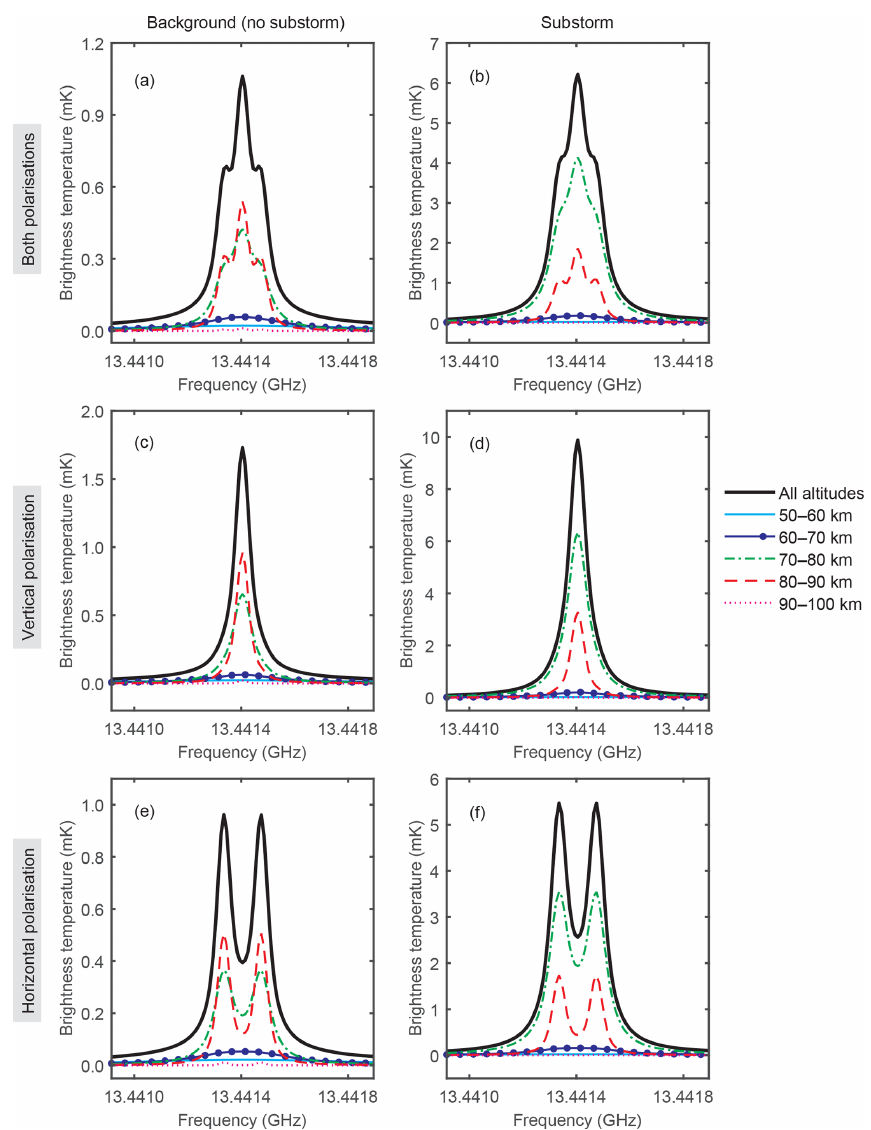
Figure 7. Simulated atmospheric spectra for the hydroxyl (OH) 13.441GHz emission line in clear-sky December conditions using a ground- based radiometer with 10kHz frequency resolution, 82 ◦ zenith angle, and 0 ◦ azimuthal angle located at Kilpisjärvi (69 ◦ 03 (cid:48) N, 20 ◦ 48 (cid:48) E), Finland. Contributions from other atmospheric species have been removed to show changes in the brightness temperature spectra due to OH. Black solid curves show the overall OH emission from all altitudes. Coloured lines show the contributions from 10km altitude intervals in the range 50–100km. Panels (a) and (b) are for all sensor polarisations in background (no substorm) and substorm conditions respectively. Similarly, (c) and (d) are for vertical sensor polarisation and (e) and (f) are for horizontal sensor